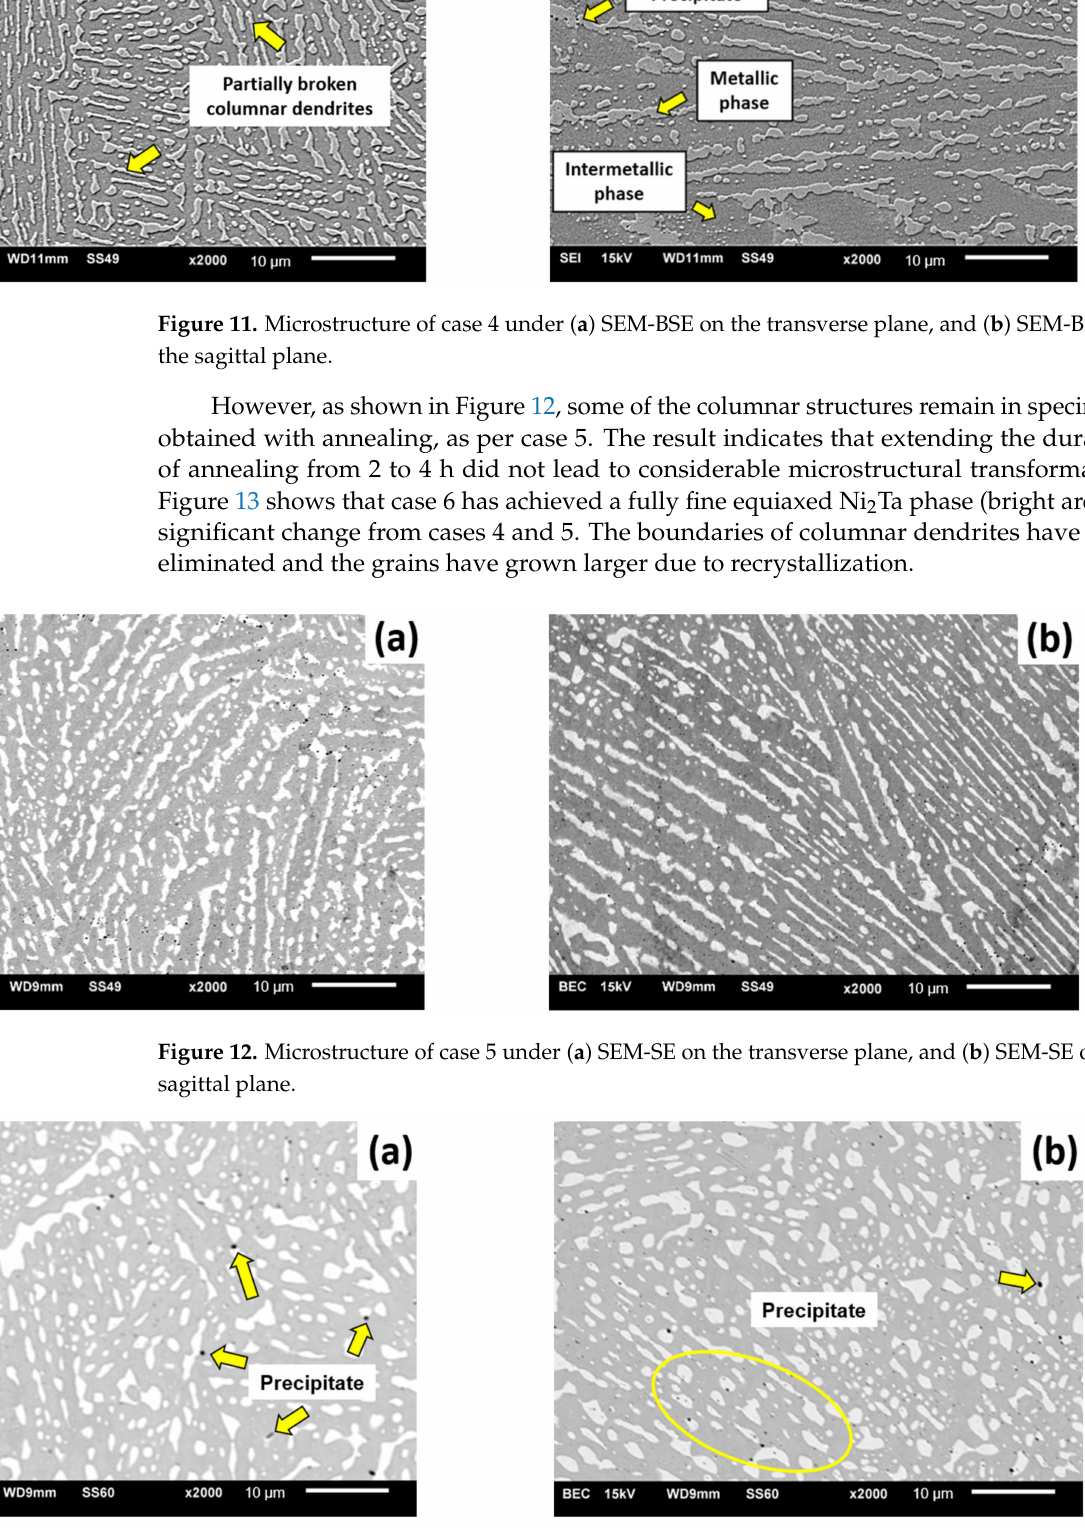
Figure 13. Microstructure of case 6 under ( a ) SEM-BSE on the transverse plane, and ( b ) SEM-BSE on the sagittal